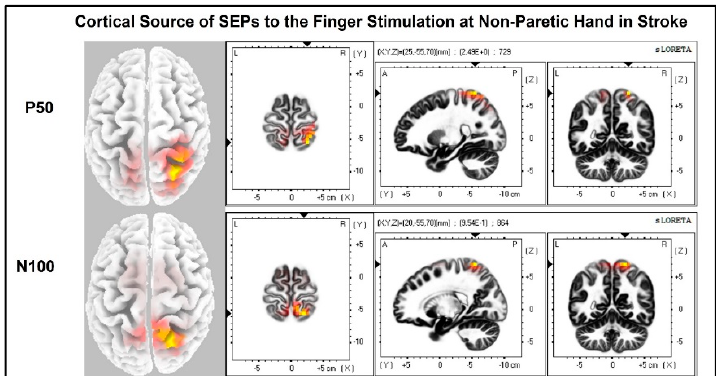
Figure 10. Cortical sources of SEP components in stroke when the non-paretic hand is stimulated. Non-paretic (left) hand was stimulated, and contralateral (right) source activities were detected mainly at the time points of P50 and N100.